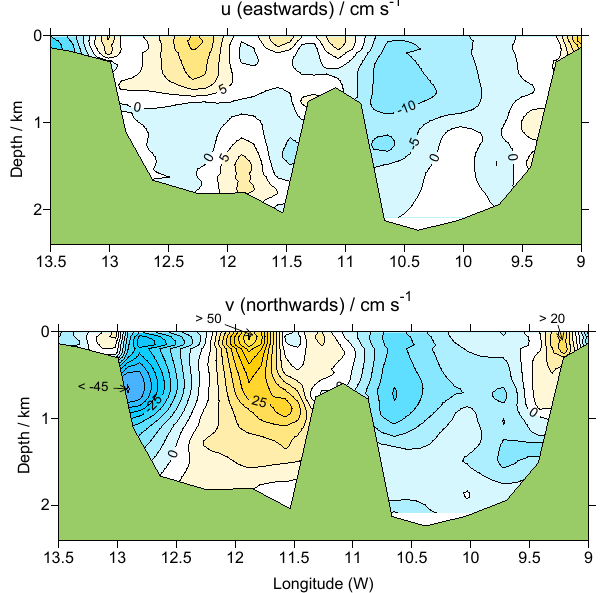
Figure 4. Full-depth LADCP sections of currents in mid-June 2009 along the Ellett Line. The upper panel shows zonal currents across the trough and the lower panel shows meridional currents. Tidal currents may be aliased in water less than 150m. Kriging interpo- lation was used to map contours to the seabed. The approximate bathymetry is defined by the depth of each